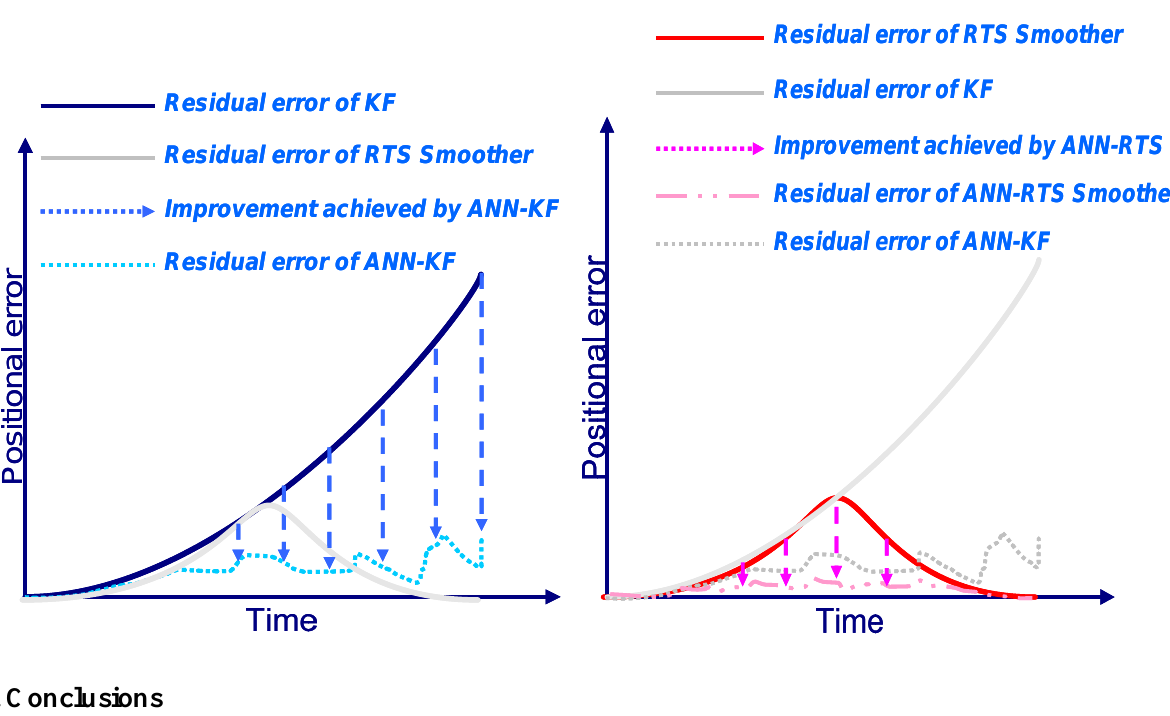
Figure 17. The contribution of proposed ANN-RTS smoother